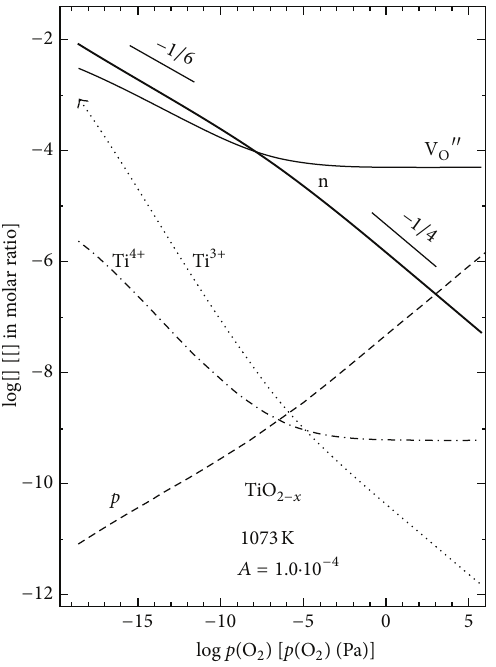
Figure 2: Oxygen vacancies and Ti-related defects (OTDs) related 𝑛/𝑝 -type TiO 2 at 1073 K [8].